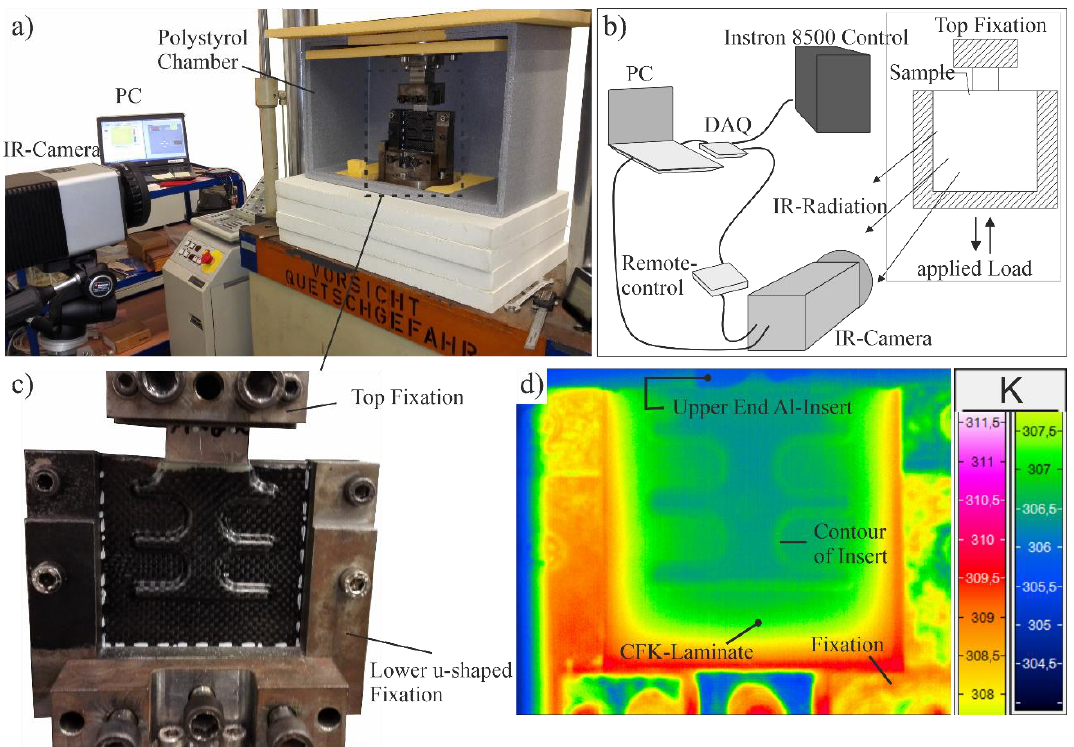
Figure 2. ( a ) Experimental setup with Instron 8500, thermography-camera and computer, ( b ) illustration of experimental setup with remote-control unit to synchronize IR-Camera and fatigue testing, ( c ) generic u-shaped fixation of specimens, ( d ) raw IR-image of specimen mounted in u-shaped fixation.